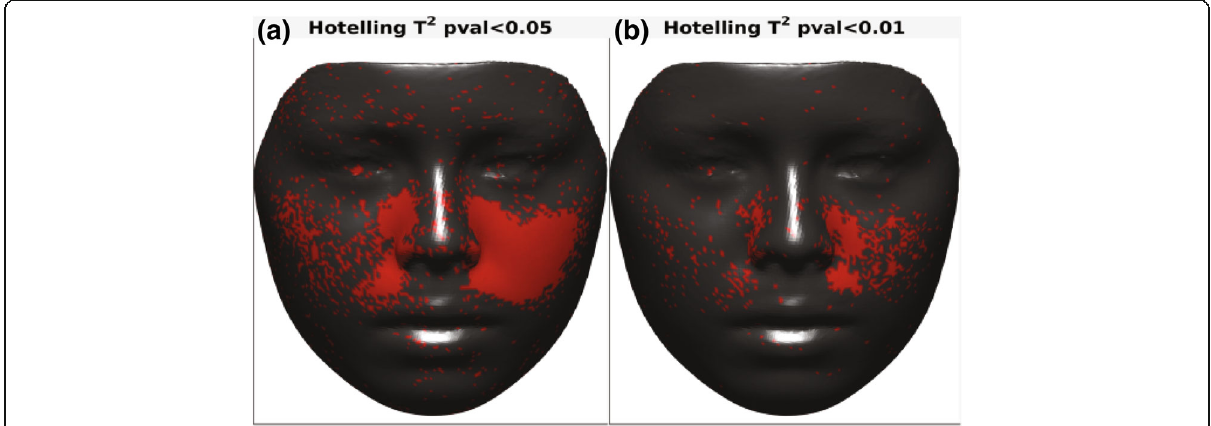
Fig. 7 P-map illustration for comparison of T0 (initial, right before MSE placement) – T2 (retention, 1 year after termination of expansion) time points with p < 0.05 ( a ) and p < 0.01 ( b )